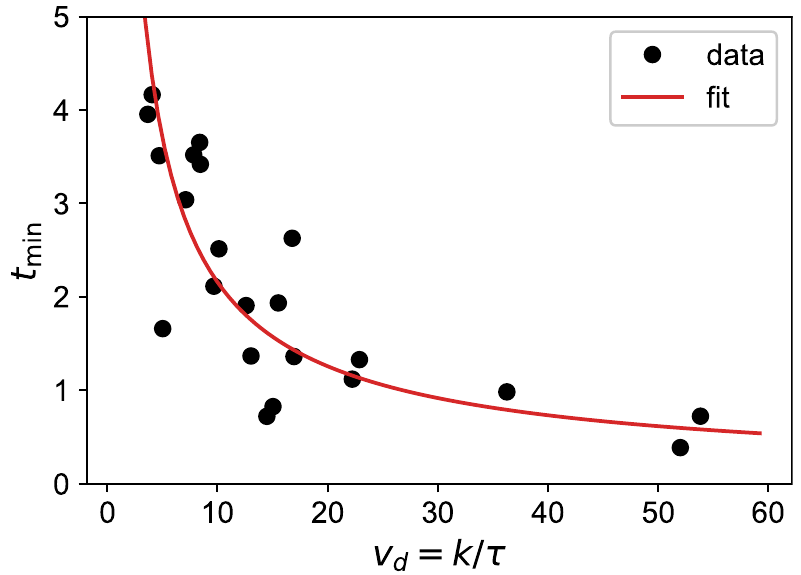
Fig 9. Correlation between v